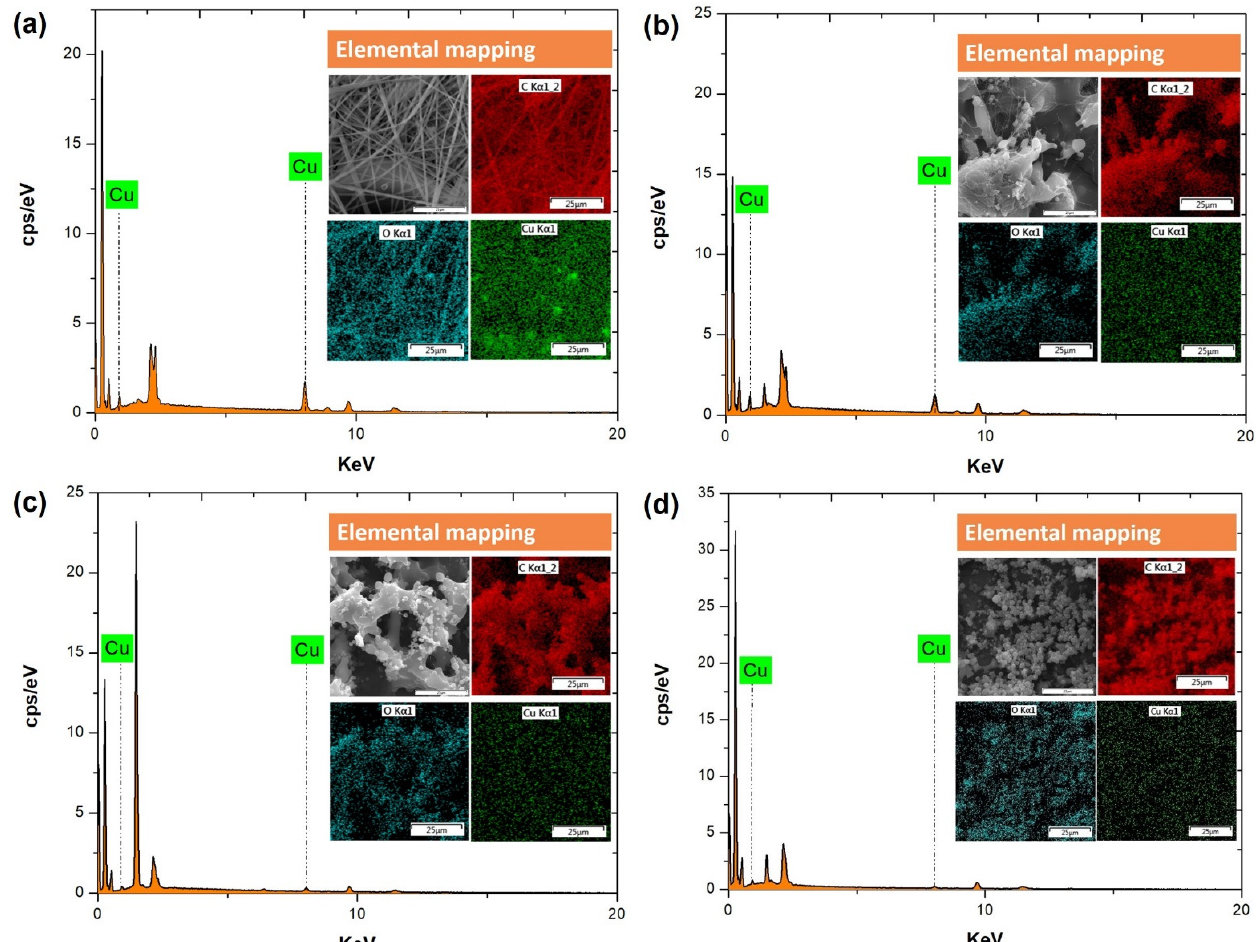
Figure 5. Elemental mapping and EDS spectra after the processing of the spun A ( a ), sprayed A ( b ), sprayed B ( c ), and sprayed C solutions ( d ).